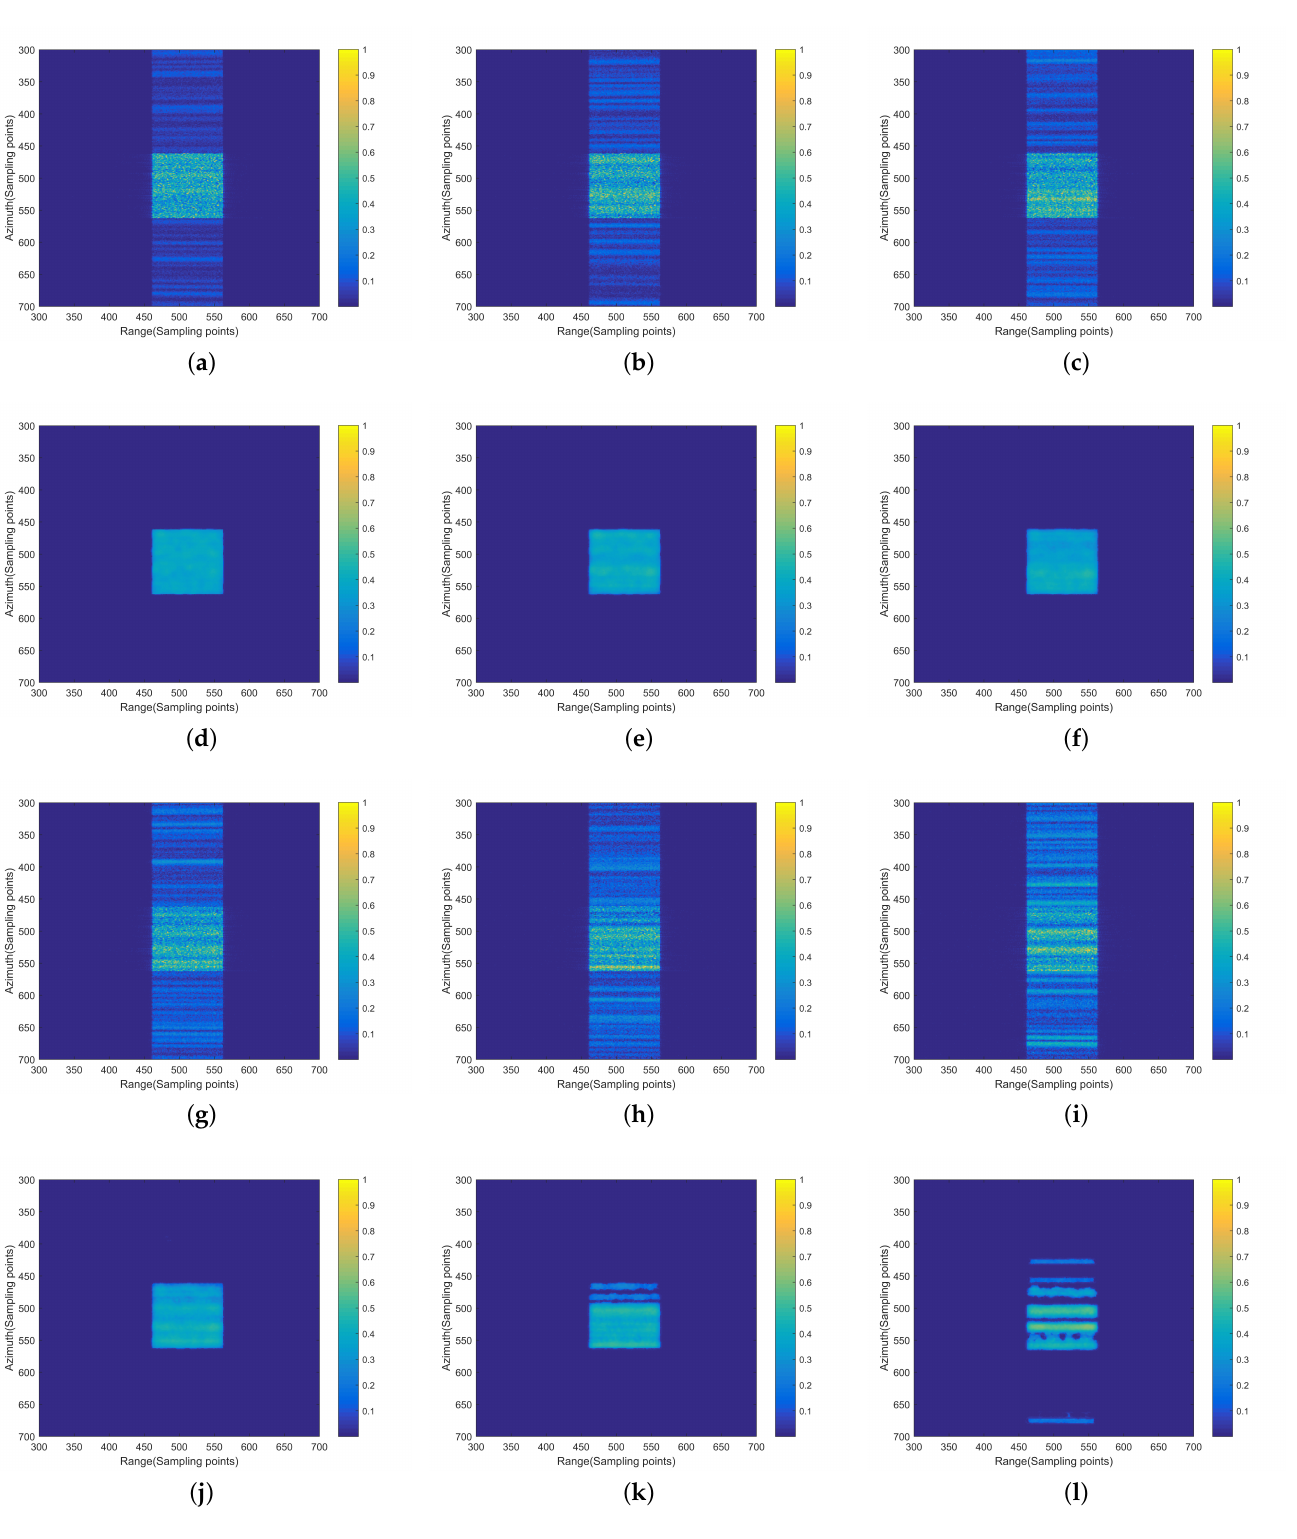
Figure 9. Simulation results under different downsampling conditions. ( a – c , g – i ): the reconstruction results of the chirp scaling algorithm. ( d – f , j – l ): the reconstruction results of the proposed method. The top two rows: from left to right the ratios of azimuth downsampling are 80%, 70% and 60%. The bottom two rows: from left to right the ratios of azimuth downsampling are 50%, 40% and